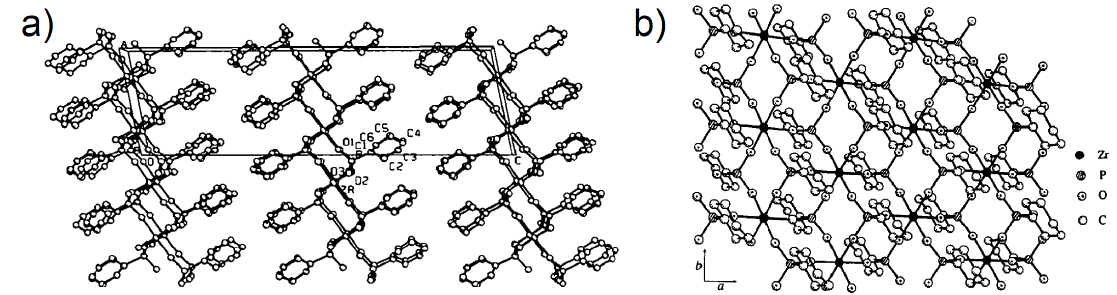
Figure 4. ( a ) Crystal structure of Zr(C 6 H 5 PO 3 ) 2 viewed along the b -axis, and ( b ) and perpendicular to the layer. Reprinted with permission from reference [23]. Copyright 1993, International Union of Crystallography.